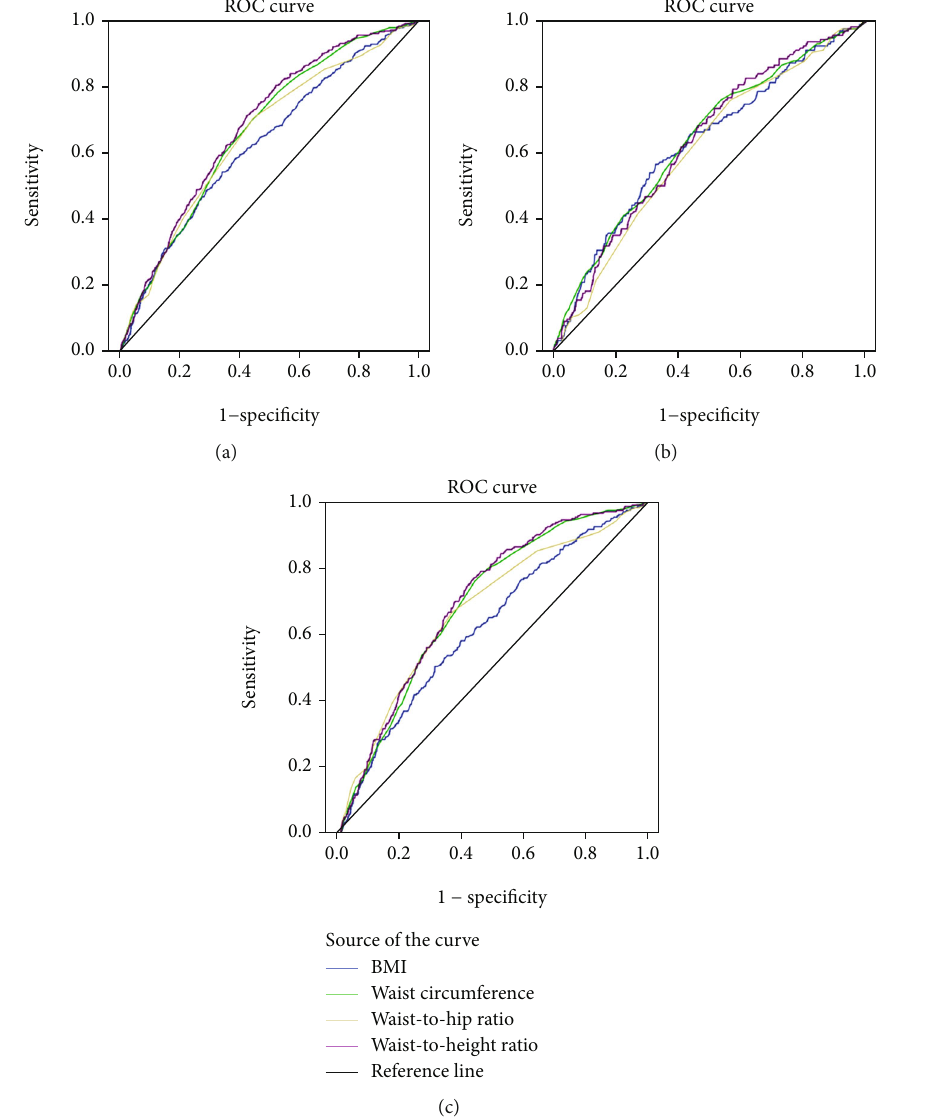
Figure 1: ROC curves of the body fat-measuring indices for diabetes (a). ROC curves of the body fat-measuring indices for diabetes in males (b). ROC curves of the body fat-measuring indices for diabetes in females